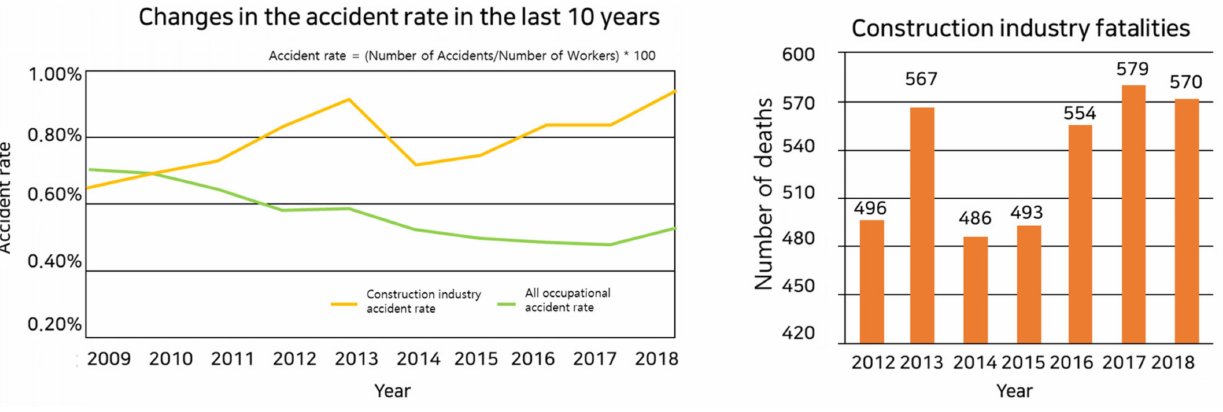
Figure 1. Accident rate and number of deaths in construction